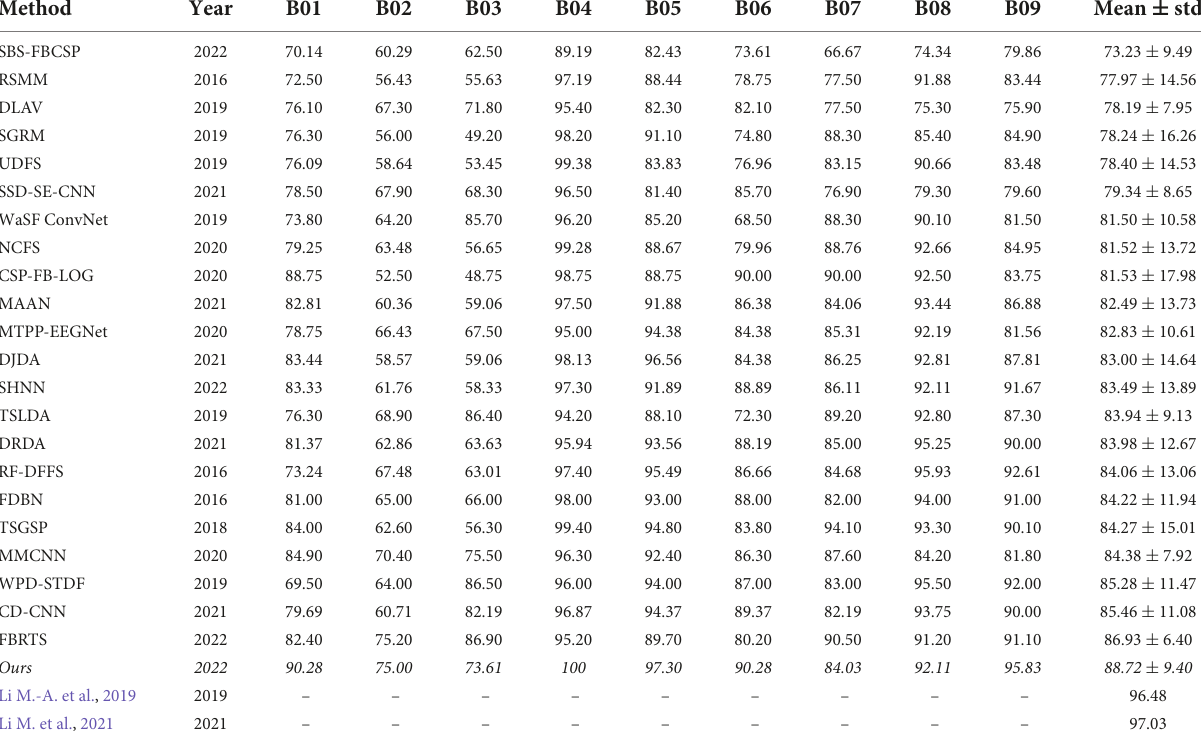
TABLE 2 Performance comparison for dataset 1, sorted by accuracy.